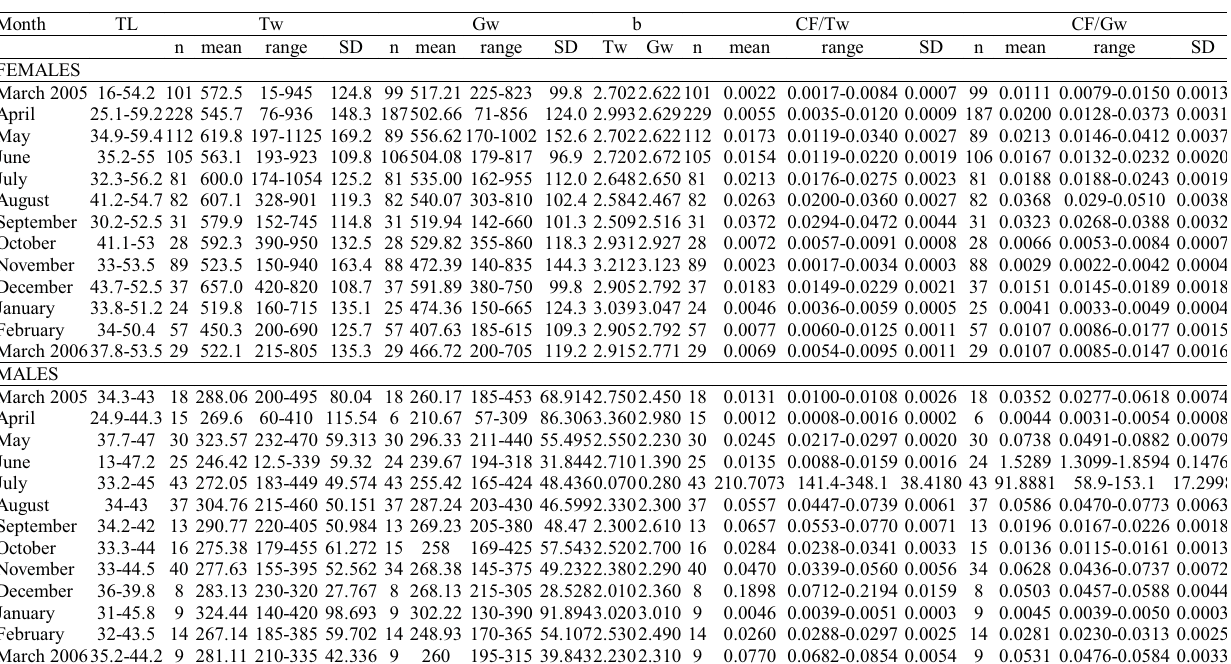
Table 4. Monthly range, standard deviation (SD), and sample size (n) for total weight (Tw), gutted weight (Gw), angular coefficient (b), and CF, calculated with both total and gutted weight (g) by total length range for males and females of Rioraja agassizi